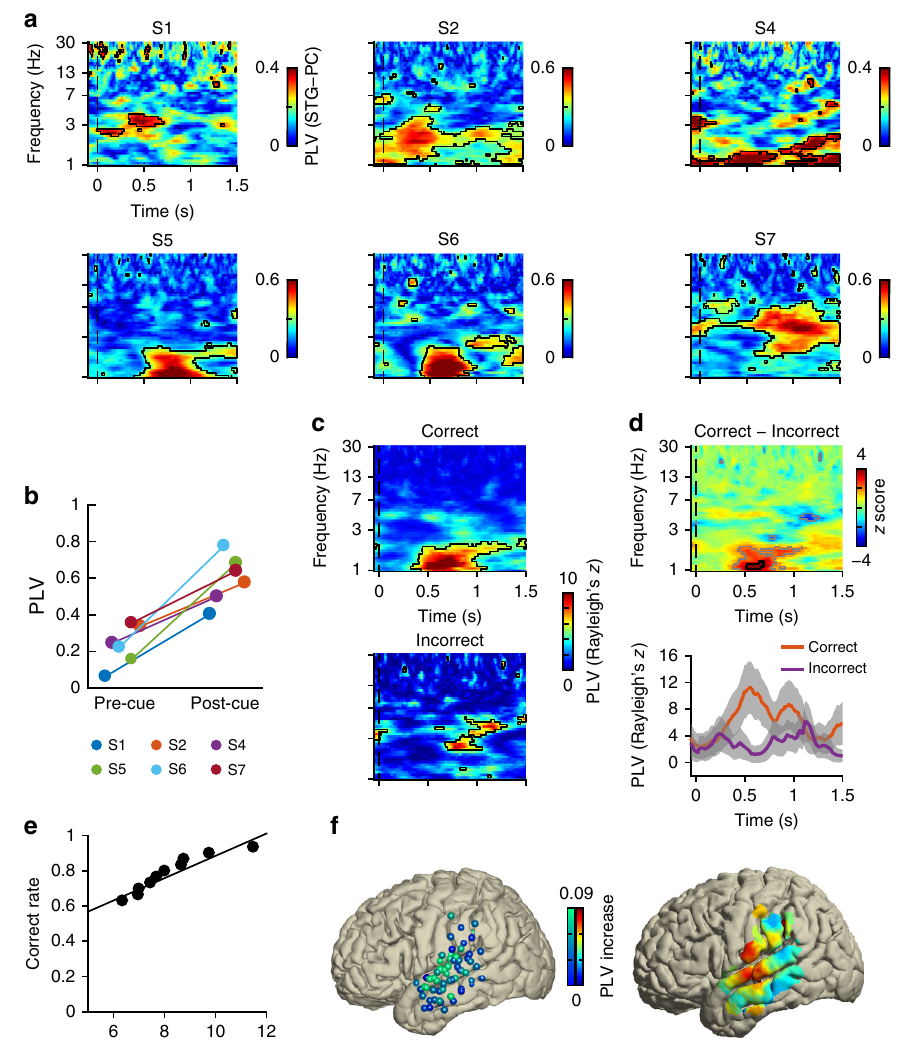
Fig. 4 Auditory cue-induced phase synchronization between auditory and olfactory cortices. a Raw phase-locking value (PLV) computed between auditory cortex (STG) and piriform cortex (PC) is shown for each participant (S1 – S2, S4 – S7). Black outlined areas indicate statistically signi fi cant clusters (false discovery rate (FDR) corrected p < 0.05, Rayleigh test). The dashed line indicates the onset of the auditory cue. Note that we did not compute PLV for S3 because this participant did not complete enough trials for individual-level PLV analysis (see Methods). b Auditory cue-induced PLV increases at the individual participant level. PLV strength before and after auditory cues was compared using a two-tailed paired t test ( t (5) = 6.44, p = 0.0013). c Phase synchronization between primary auditory and olfactory cortices was stronger during correct compared to incorrect trials. PLV is shown computed for correct (top) and incorrect (bottom) trials separately. Dashed lines indicate the onset of auditory cues. d Phase synchrony was stronger when the participant's response was correct. Direct statistical comparison between correct and incorrect trials is shown in the upper panel. Black outlines indicate statistically signi fi cant clusters (FDR corrected p < 0.05, permutation test) and gray outlines indicate statistically signi fi cant clusters at uncorrected p < 0.05. The lower panel shows the averaged PLV time series at the peak frequency. Gray shaded areas denote the standard error obtained through bootstrapping. e PLV strength predicts future accuracy. Bootstrapped PLV values are shown plotted against the mean accuracy of the subset of trials included in each repetition. The strength of PLV for each subset of trials strongly correlates with the future behavioral accuracy ( r = 0.943, p = 0.000043, Pearson's correlation). f Auditory cue-induced PLV is maximal between PC and STG. All parietal electrodes for all participants are shown as dots overlaid on the standard Montreal Neurological Institute (MNI) brain. On the left, each dot represents one electrode, color-coded by the strength of cue-induced PLV between PC and that particular electrode; greener colors indicate stronger PLV. On the right, raw PLV values are shown interpolated into a heat map overlaid on the standard MNI brain surface; warmer colors indicate stronger